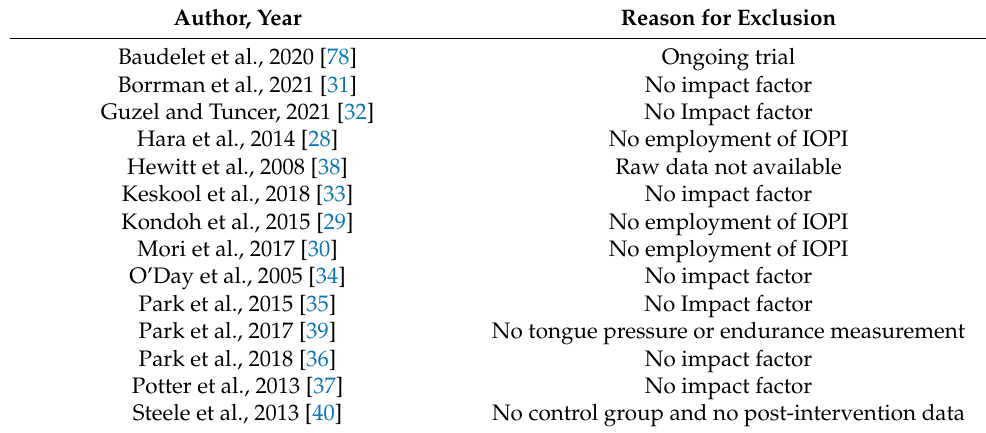
Table 2. List of excluded studies (#14) and reasons for